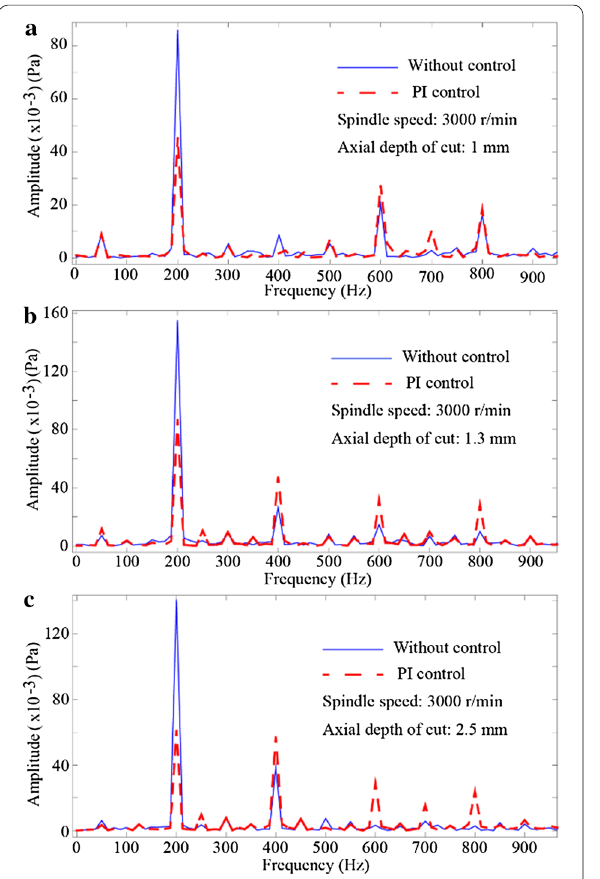
Figure 8 FFT of displacement signals at a spindle speed of 3000 r/min: ( a ) at an axial depth of cut of 1 mm, ( b ) at an axial depth of cut of 1.3 mm, and ( c ) at an axial depth of cut of 2.5 mm